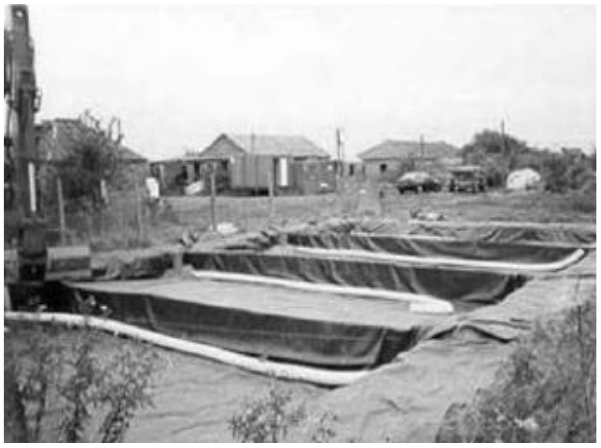
Figure 9. Construction of four pilot-scale cells in the site. Cell 1: untreated soil; Cell 2: EnvirOceM soil; Cell 3: OPC soil; Cell 4: ACT soil (from Jiangying et al . [38] with permission of Elsevier ).